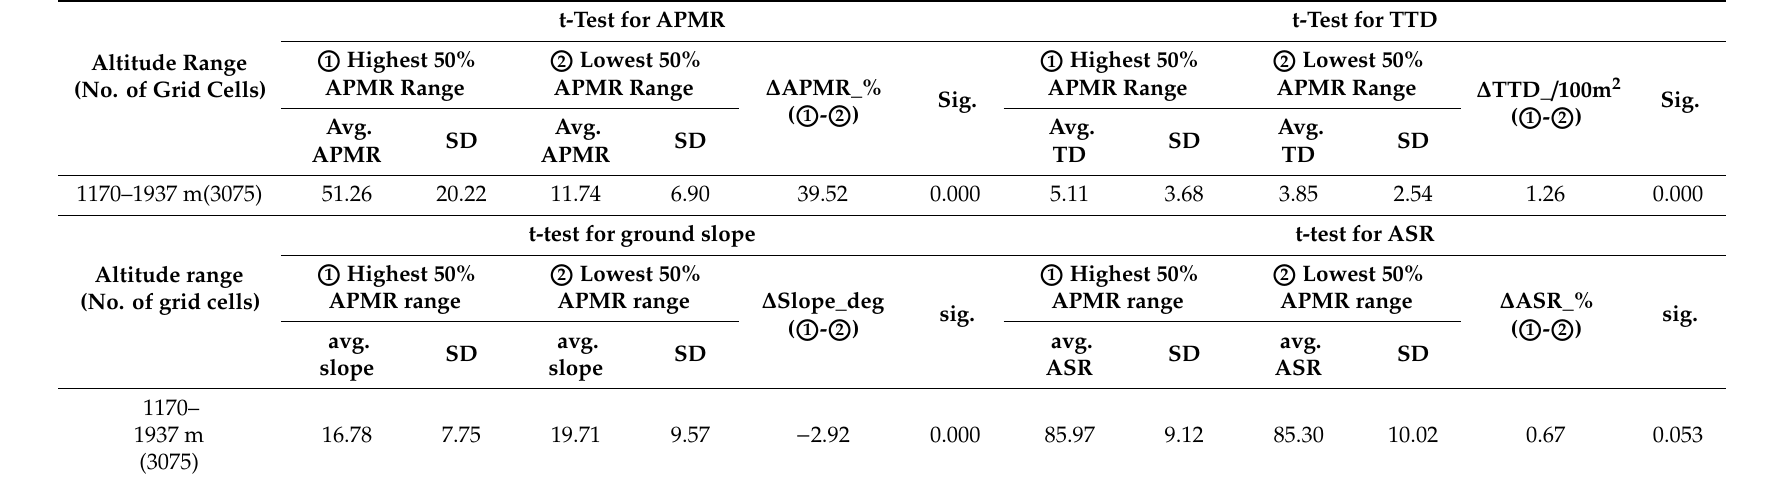
Table 3. t-test for APMR, tree density, ground slope, and ASR between one cell group with the highest 50% APMR range and another cell group with the lowest 50% APMR range, from 1300 m to 1900 m in